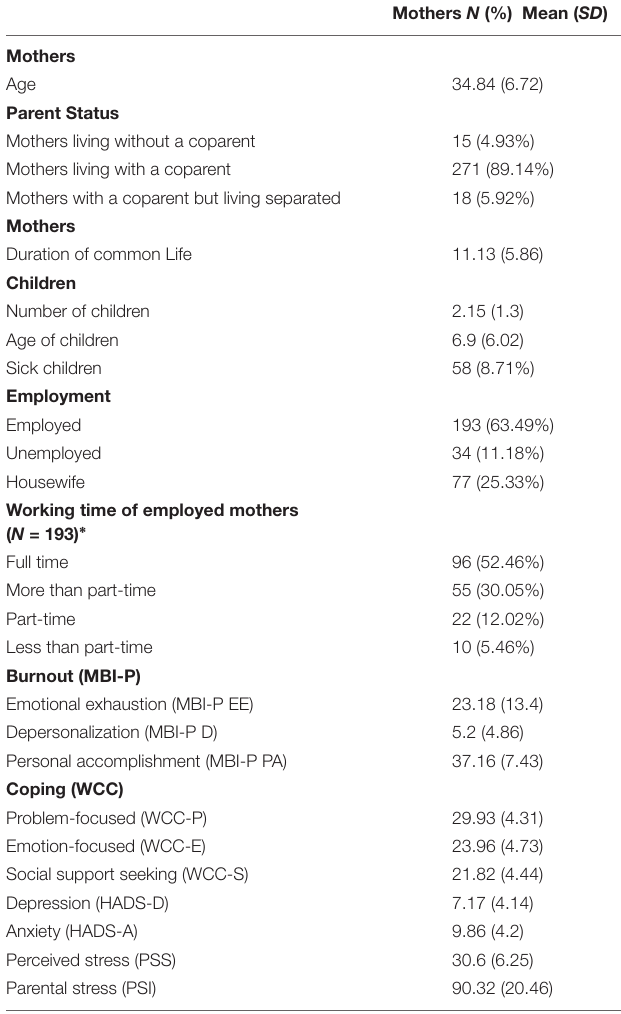
TABLE 1 | Descriptive characteristics of the sample ( N =